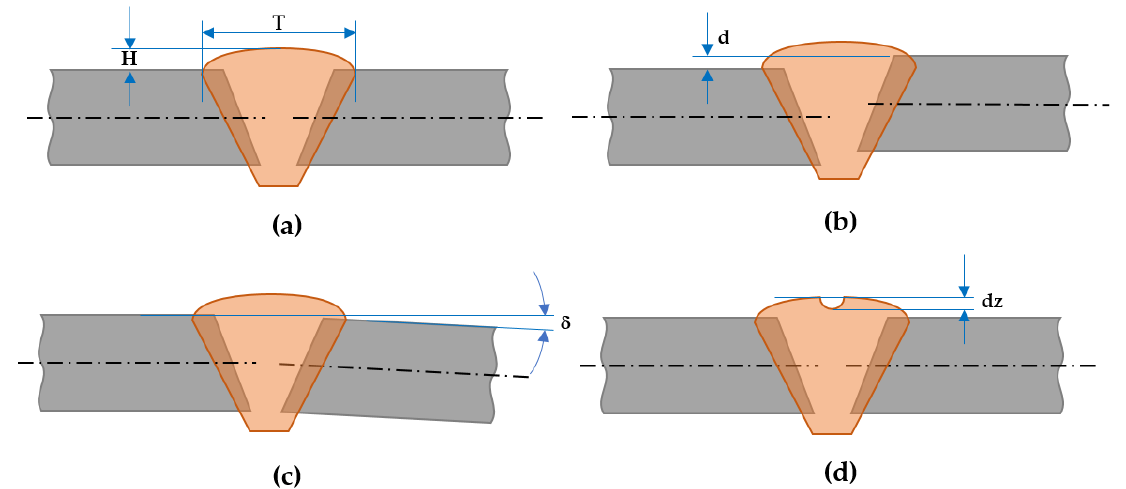
Figure 2. Defects and quality criterions considered in the WELDMAP software: ( a ) excess weld metal; ( b ) linear misalignment; ( c ) angular misalignment; ( d ) crater. ( b ) linear misalignment; ( c ) angular misalignment; ( d )